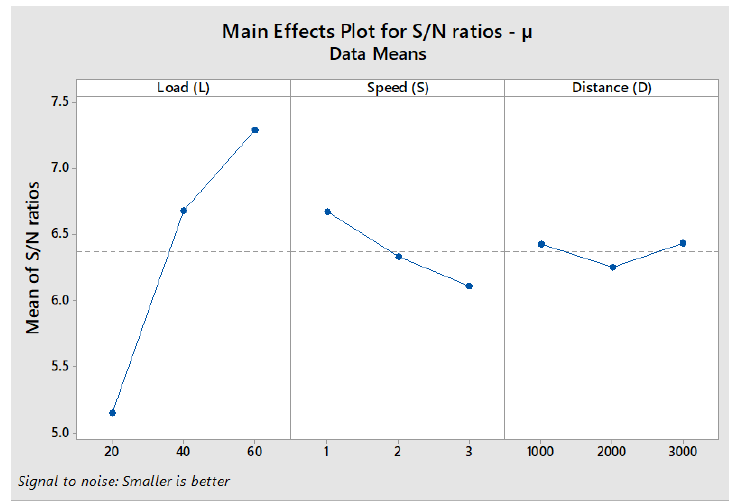
Figure 3. Main Effects Plot for S/N Ratios of µ.